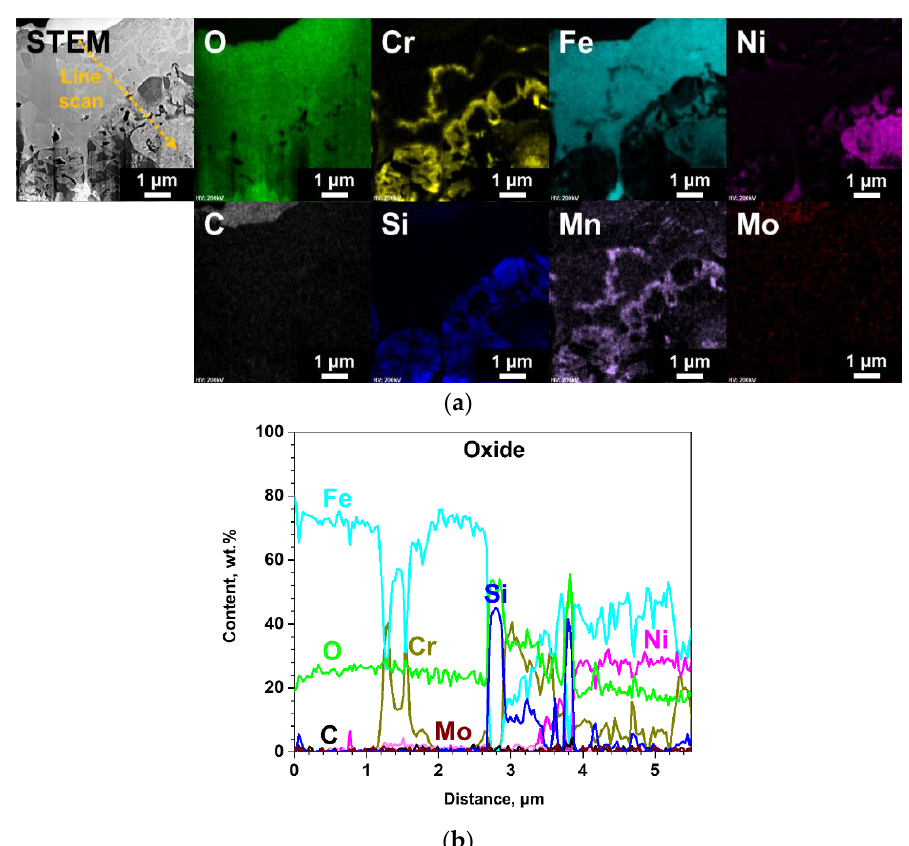
Figure 10. TEM analyses results of the surface-modified SS 316LN after exposure to steam at 650 °C (0.1 MPa) for 500 h; ( a ) STEM image with EDS mapping images, and ( b ) result of EDS line scan along the dotted line in STEM micrograph in (a).